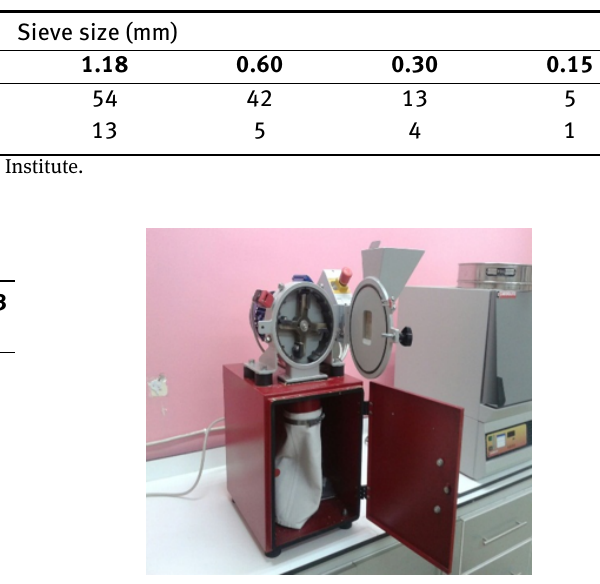
Table 2: Sawdust and sand particle grading.